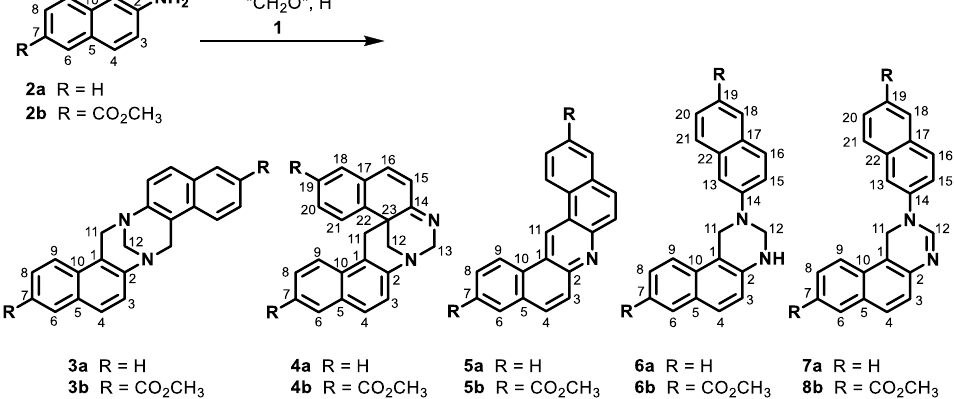
Scheme 1. Previously described products of the reaction of formaldehyde with 2-naphthylamines